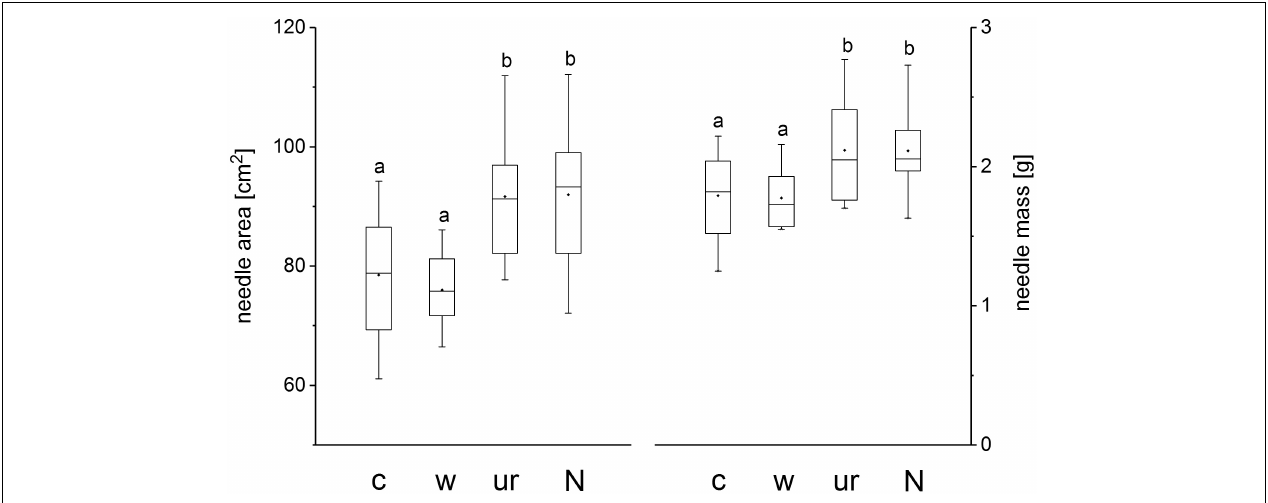
FIGURE 3 | Box plots showing the median, lower (25%) and upper (75%) quartile and minimum and maximum of 100 needle area and 100 needle mass of Pinus cembra trees in control (c), warmed (w), understory removal (ur) and N fertilized (N) plots at the end of the growing season 2013. Different letters indicate significant differences at P < 0.05.